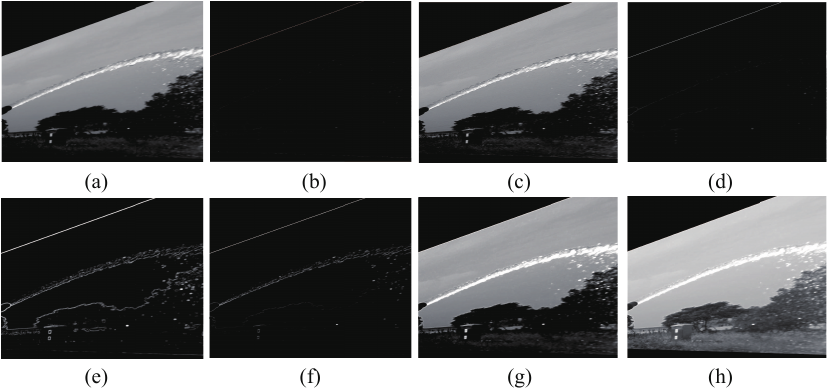
Figure 4. Example of calculation results for each step in the image enhancement process. ( a ) Original image; ( b ) Laplacian transformation; ( c ) a + b; ( d ) Sobel gradient; ( e ) mean filter; ( f ) masking image; ( g ) crisp enhancement; ( h ) grayscale